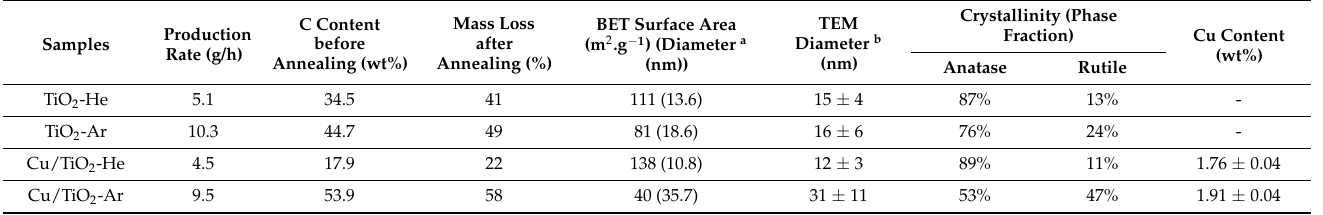
Table 1. Characteristics of TiO 2 and Cu x O y /TiO 2 elaborated under He and Ar atmospheres. (Unless specified, characterisation results concern annealed powders).